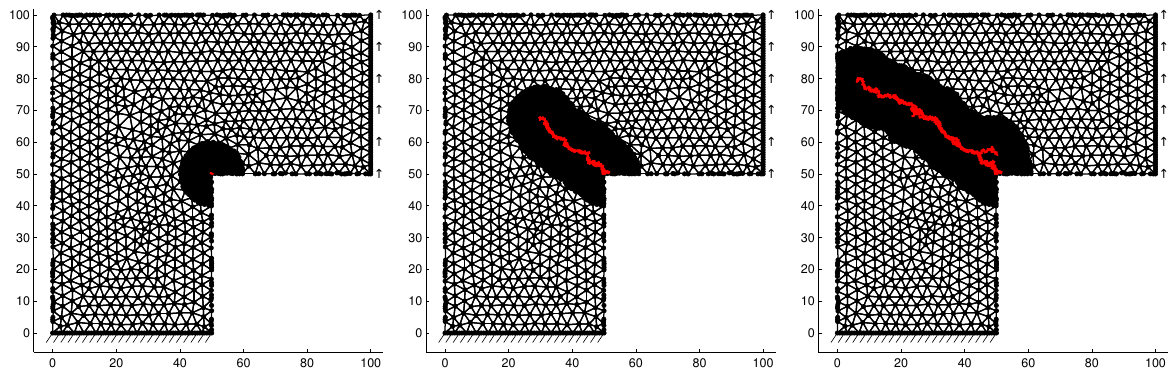
Figure 1. Interpolation elements and area of high interest (black) and broken links (red) in the first (left), 100-th (middle) and the last step of simulation (right).